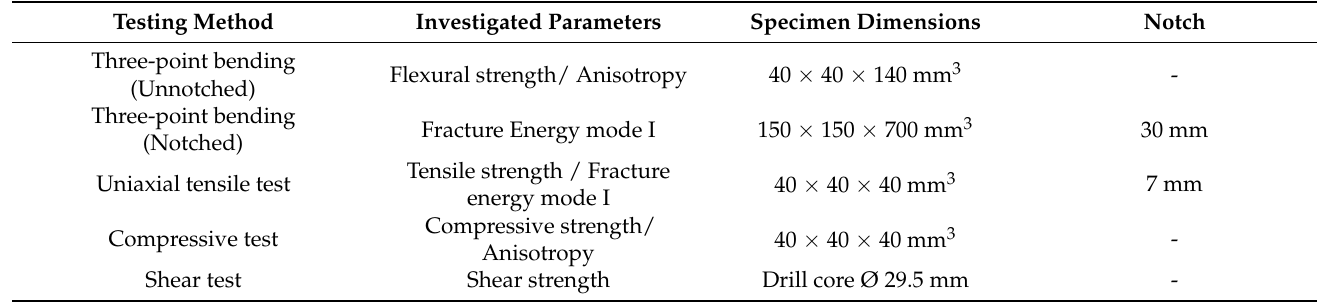
Table 2. Specimen dimensions regarding testing method and target